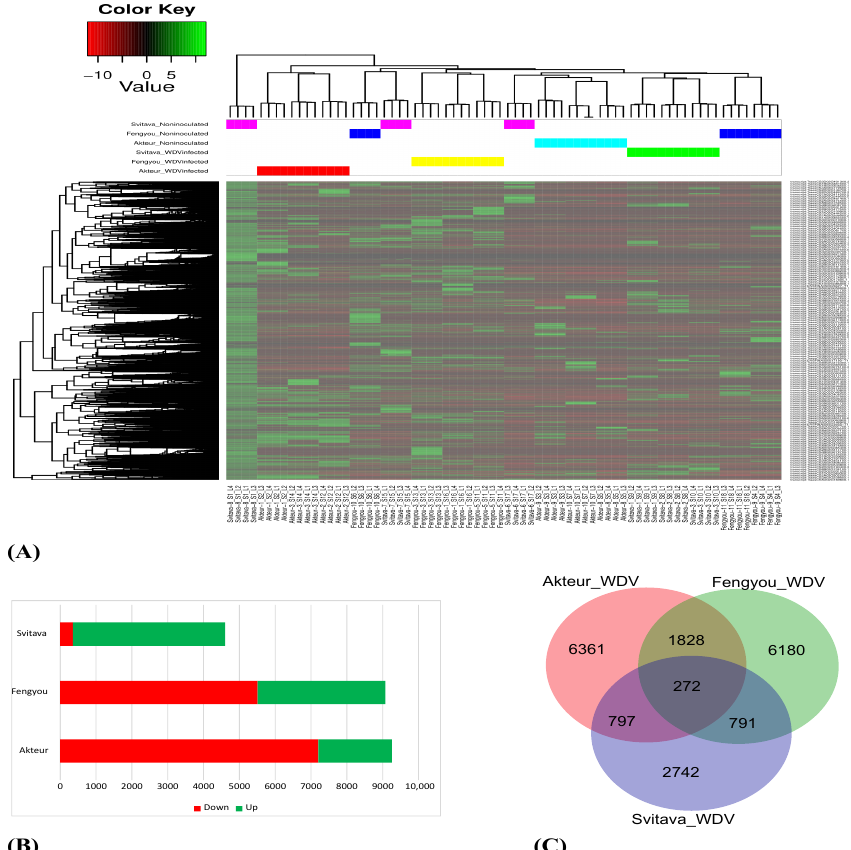
Figure 3. Summary of differential expression in WDV-infected and non-inoculated genotypes. ( A ) Heatmap of transcript expression and hierarchical clustering analysis of the WDV-infected and non-inoculated genotypes. ( B ) A bar chart showing the number of differentially expressed transcripts (DETs) in the three genotypes after WDV infection. ( C ) A Venn diagram showing the overlaps of the DETs of the three genotypes after WDV